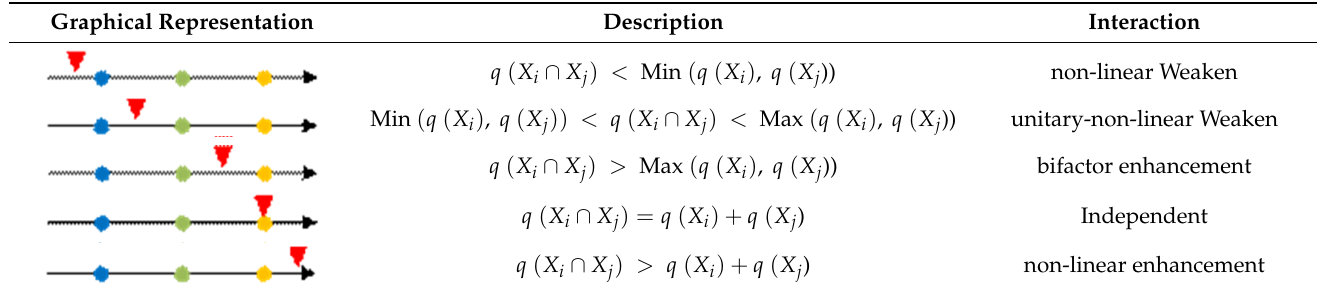
Table 1. Interaction between Explanatory Variables. Graphical Representation